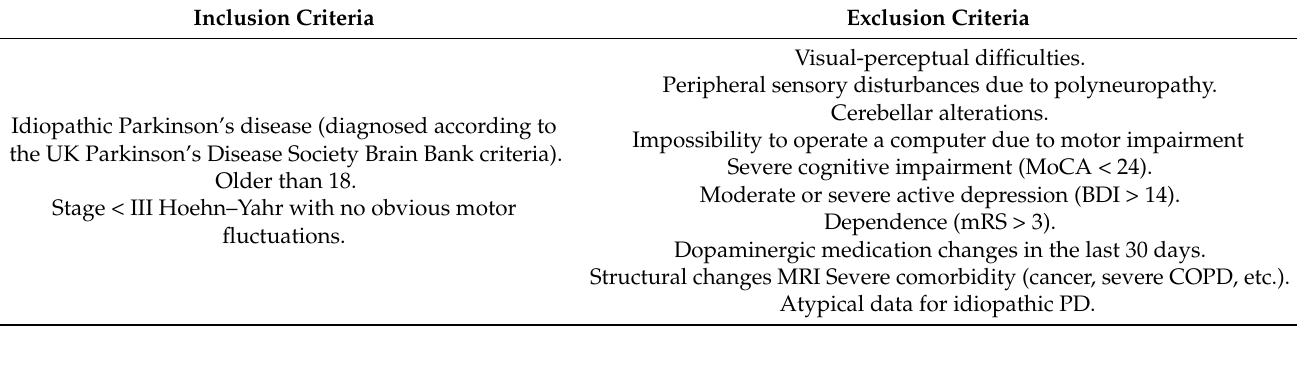
Table 1. Inclusion and exclusion criteria.